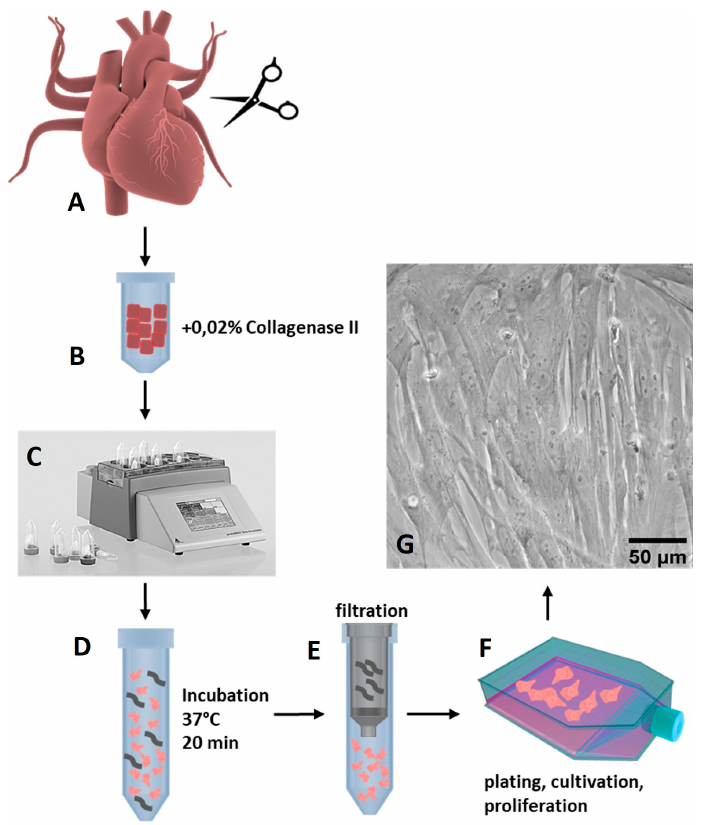
Figure 1. Isolation of pCPCs with collagenase digestion. ( A ) Tissue from the left atrium, left ventricle, and apex from pig hearts was excised into small chunks and transferred to ( B ) gentleMACs C Tubes together with 0.02% collagenase II solution in medium. ( C ) The tissue was mechanically dissociated on a gentleMACS dissociator and ( D ) incubated for 20 min at 37 °C in a water bath with gentle agitation. ( E ) The cell solution was filtered, (F) and isolated cells were plated to T75 flasks. ( G ) After one week, cells reached confluency and were further expanded and cryopreserved.